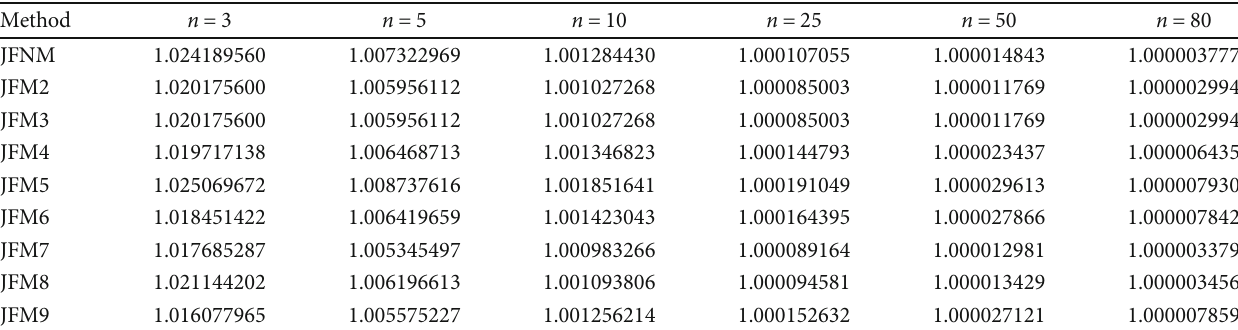
Table 30: Values of CI for the methods in the second category to solve Test Problem 1, and n = 3, 5, 10,25,50,80 .